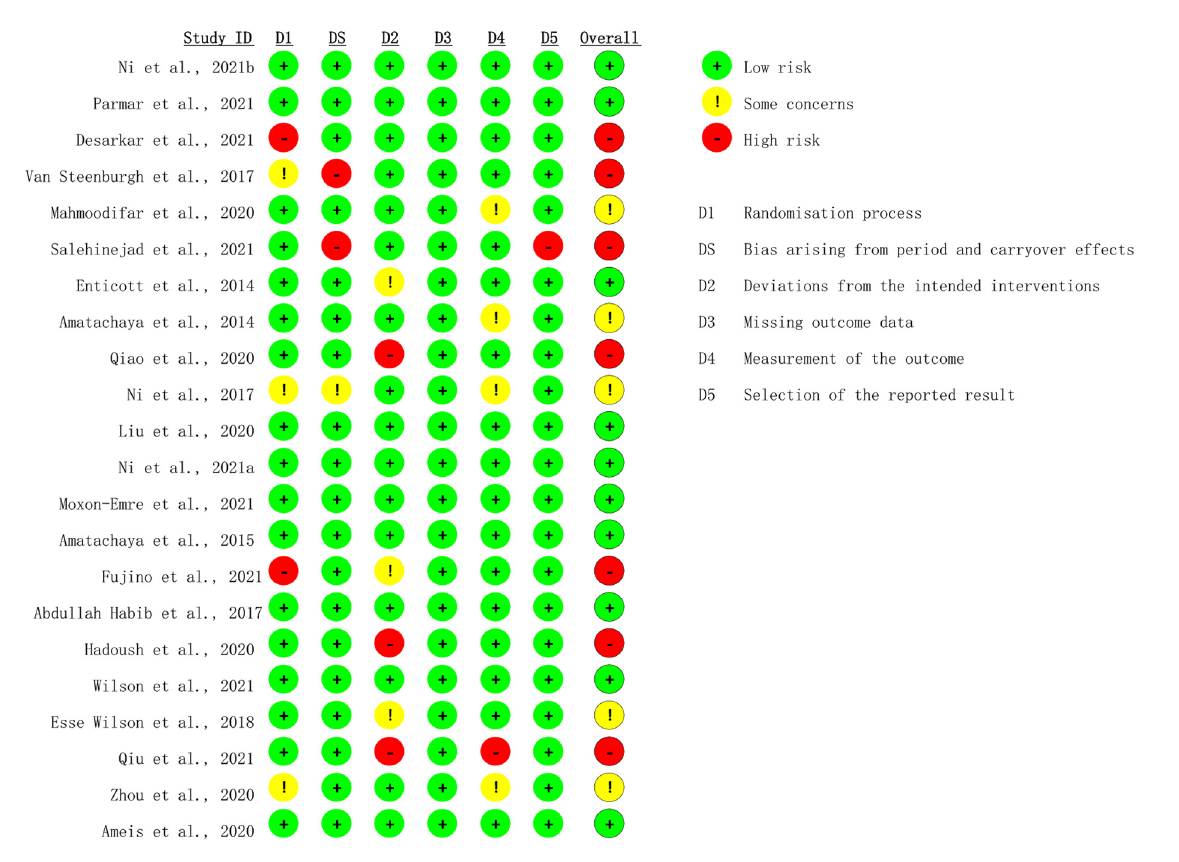
FIGURE2 Summary of risk-of-bias